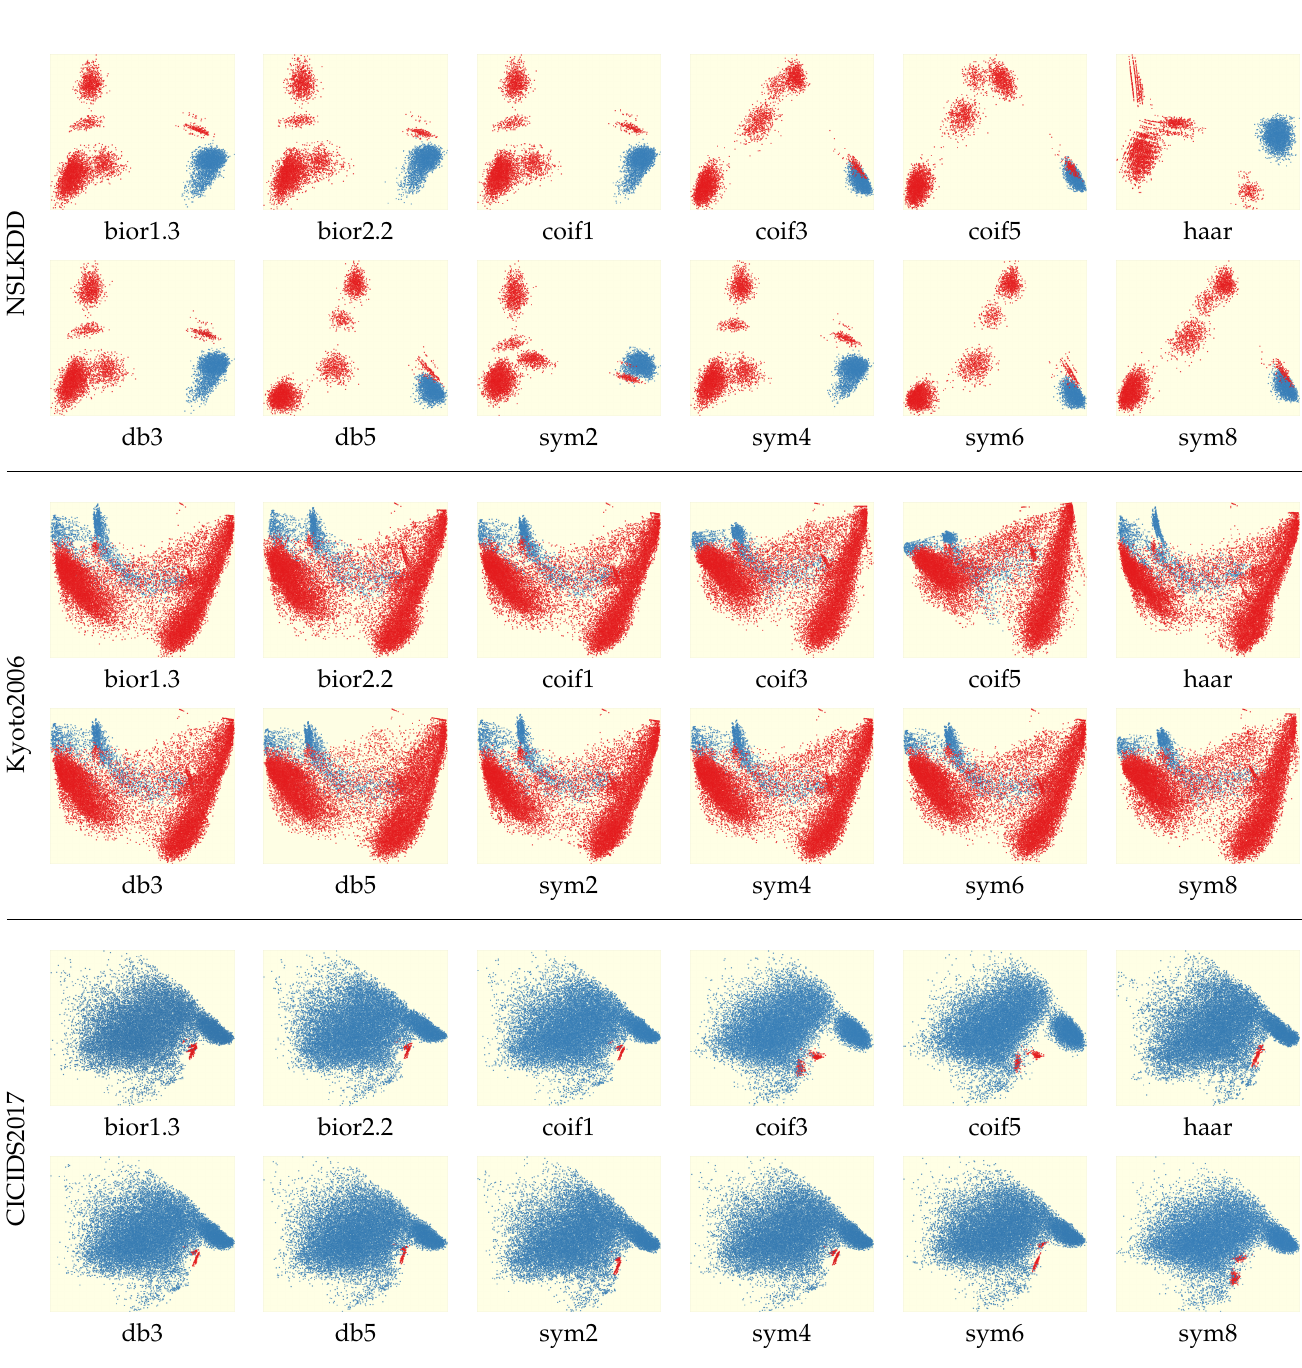
Figure 4. PCA projections of the DWT features ( α = 150 and β = 10) by utilizing different wavelets—Biorthogonal (bior), Coiflets (coif), Daubechies (db), and Symlets